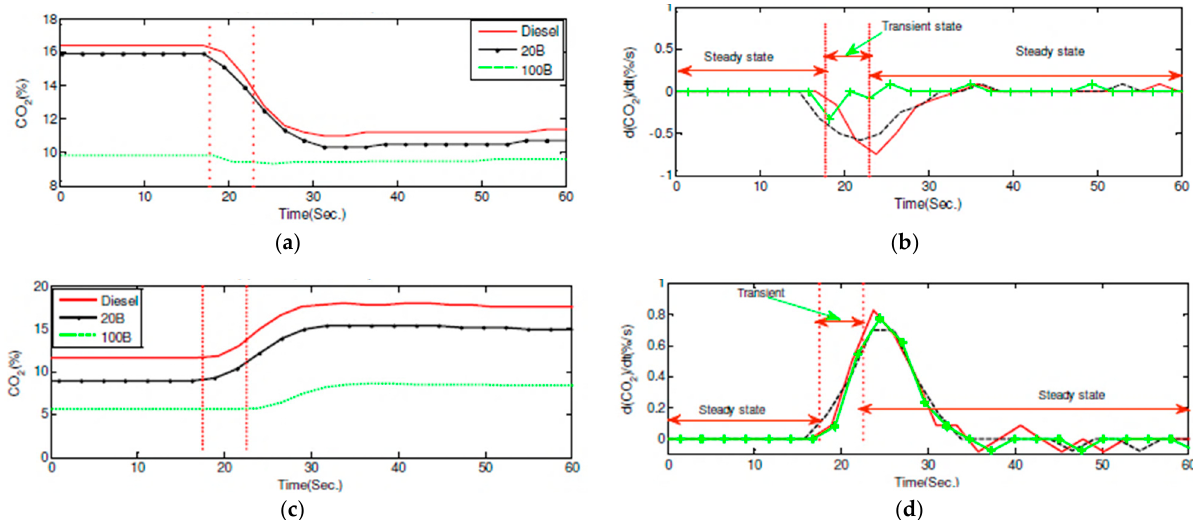
Figure 9. ( a ) Time variation of carbon dioxide emission of the CI engine with the three fuels during positive speed transient at engine load of 420 Nm; ( b ) corresponding rate of change of CO2 emission. ( c ) Time variation of carbon dioxide emission of the CI engine during negative speed transient at engine load of 420 Nm; ( d ) corresponding rate of change of CO2 emission at negative speed transient condition.